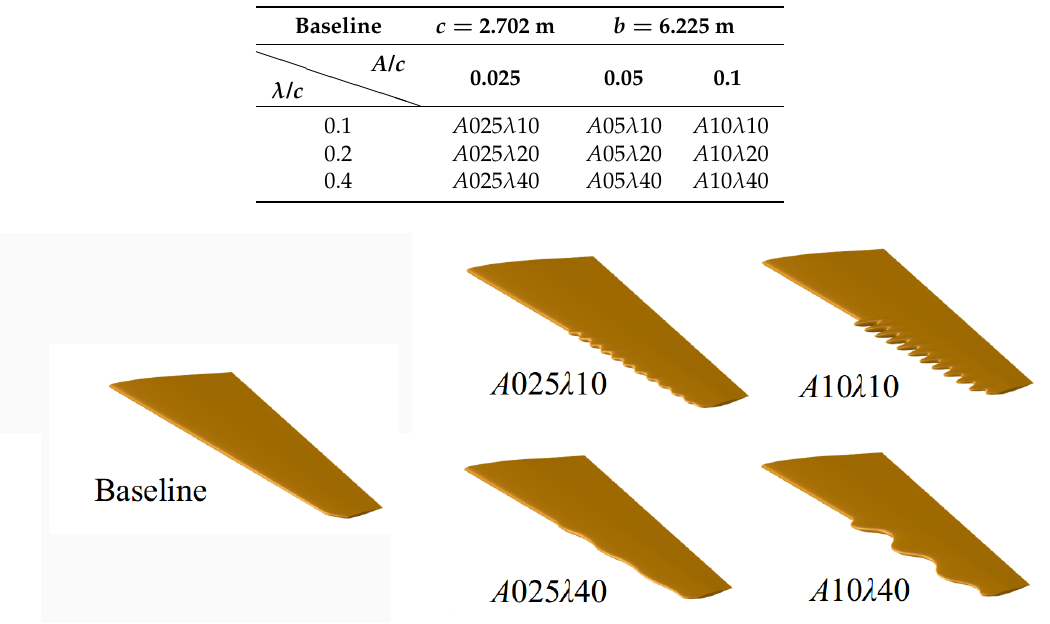
Figure 16. Wing baseline and modified geometries.